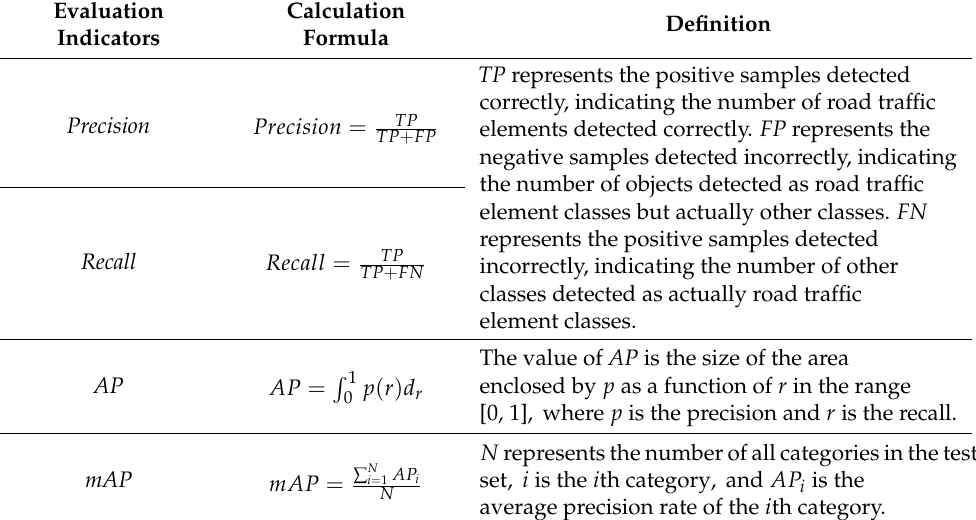
Table 2. Evaluation